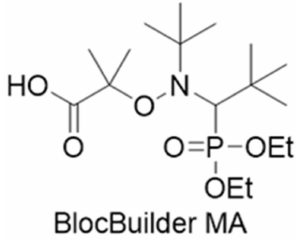
Figure 1. Chemical structure of Blocbuilder ® MA.